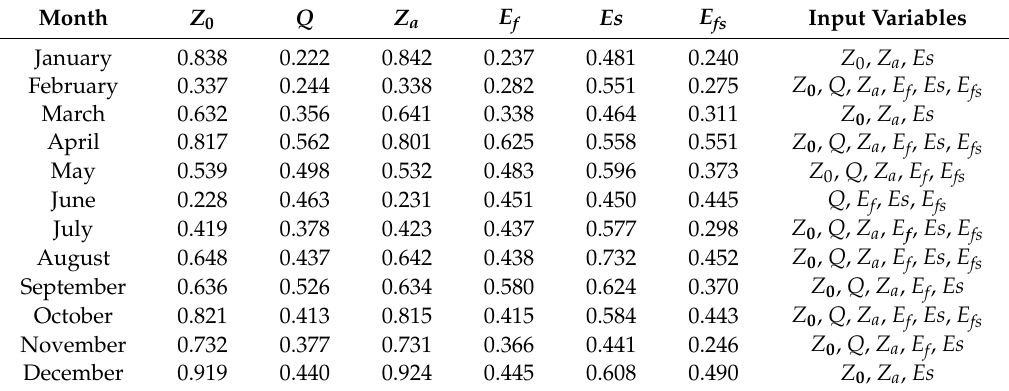
Table 11. The monthly input variables defined based on the conventional trajectory.